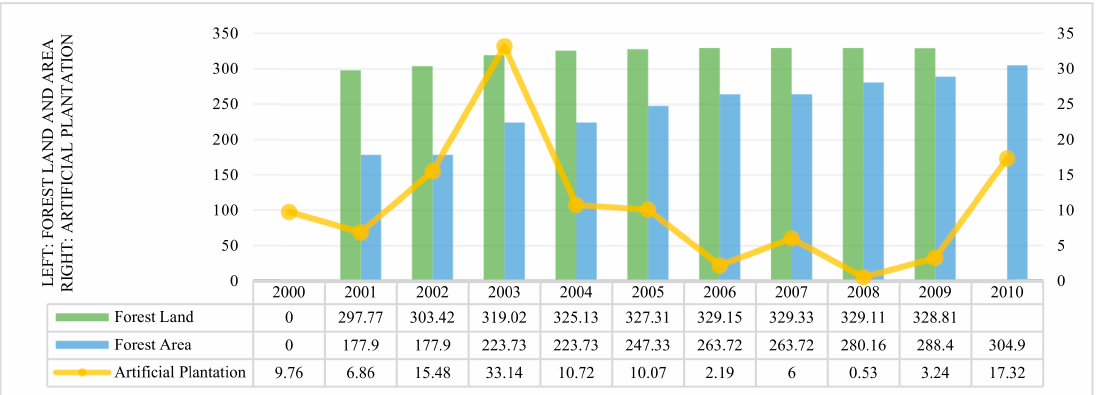
Figure 3. Annual forest change in Chongqing (2000–2010); Source: multiple statistical yearbooks.